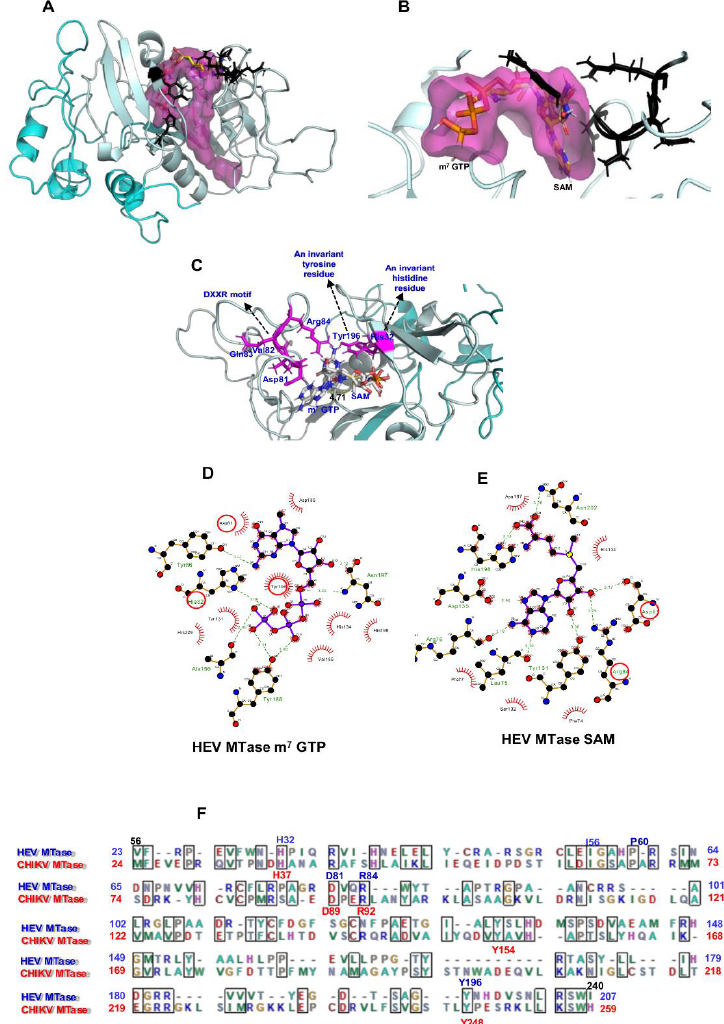
Figure 2. Computational docking of m 7 GTP and SAM on HEV-MTase model. ( A ) 3D structure model of HEV-MTase protein (region 34 – 353) after MD simulations; Putative MTase region 60 to 240 amino acid is highlighted in light cyan, and 34 – 59 to 241 – 353 amino acid regions are in dark cyan. The Surface view of the ligand-binding site in the HEV-MTase model is highlighted in dark pink. ( B ) For clarity, only the first rank pocket in the structure of HEV-MTase is shown here. Docked poses of m 7 GTP and SAM are displayed in the binding site of putative HEV-MTase protein. The active site residues are shown as balls and stick with a black colour code. ( C ) Docked poses of m 7 GTP and SAM (grey carbon, blue nitrogen, red oxygen, yellow sulfur, and phosphate in pink) are displayed in the binding site of the putative HEV-MTase region. The docked poses show distance (4.71Å) as yellow dotted lines between a carbon atom of methyl group donor and N7 methyl group acceptor in the m 7 GTP and SAM binding site of HEV-MTase protein. An invariant histidine 65 residues (H32), a DXXR Motif residues Asp114, Val115, Gln116 and Arg117 (Asp81, Arg84), and the invariant tyrosine 229 residue (Tyr196) in the HEV-MTase complex with m 7 GTP and SAM are represented in red colour circles. ( D , E ) The 2D interaction diagrams. The docked poses display interactions in the m 7 GTP and SAM binding site of the HEV-MTase protein. In the charts, residues highlighted with a red circle are common in the HEV, CHIKV and SFV MTase proteins. Conserved residues His32, Asp81, Arg84, and Tyr196 were previously mutated in the SFV MTase site-directed mutagenesis study. Sidechains of interacting residues of the HEV-MTase protein are shown as sticks in pink colour. ( F ) Amino acid Sequence alignment of HEV-MTase (23 to 207 correspond to (Putative HEV-MTase 56 to240 region) and CHIKV-MTase domain 24 to 259 region. Conserved residues of HEV-MTase and CHIKV-MTase are highlighted in blue and red colours,